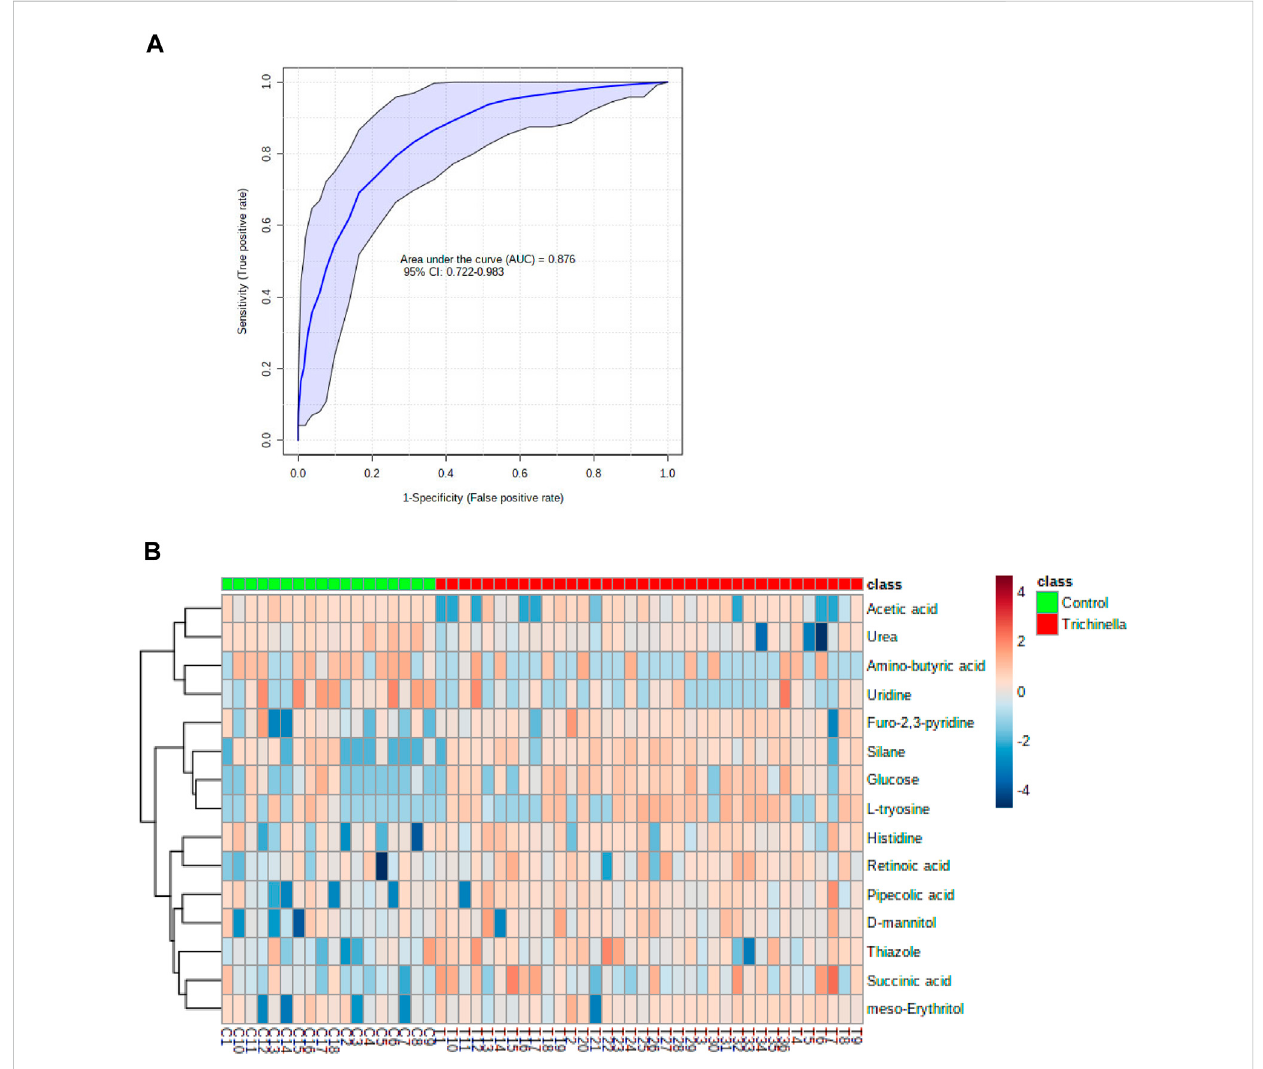
FIGURE 8 Asystemicanalysisofthekeydifferentialbiomarkers. (A) Thereceiver-operatingcurveofthetop15identi fi edpotentialbiomarkersfordistinguishing individuals with Trichinella zimbabwensis (Tz) infection. (B) Heat map visualization of the key potential biomarkers between the Tz infected and control